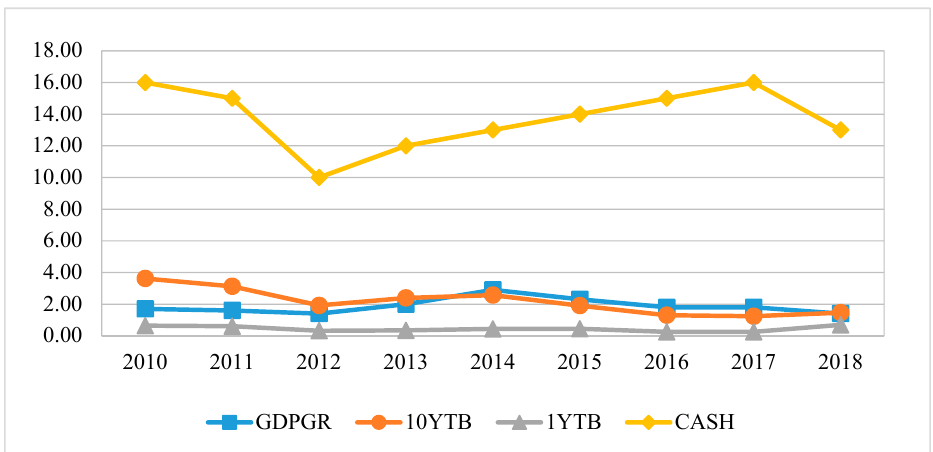
Figure 2. Firms’ cash holdings, interest rates, and GDP over time. Note: This figure plots the evolution of the average cash to asset ratio, the growth of GDP, the change of Interest Rate 1-Yr T-Bills, and 10-Yr T-Bills over time for the full sample of 6929 UK non-financial non-utility firms during 2010–2018.